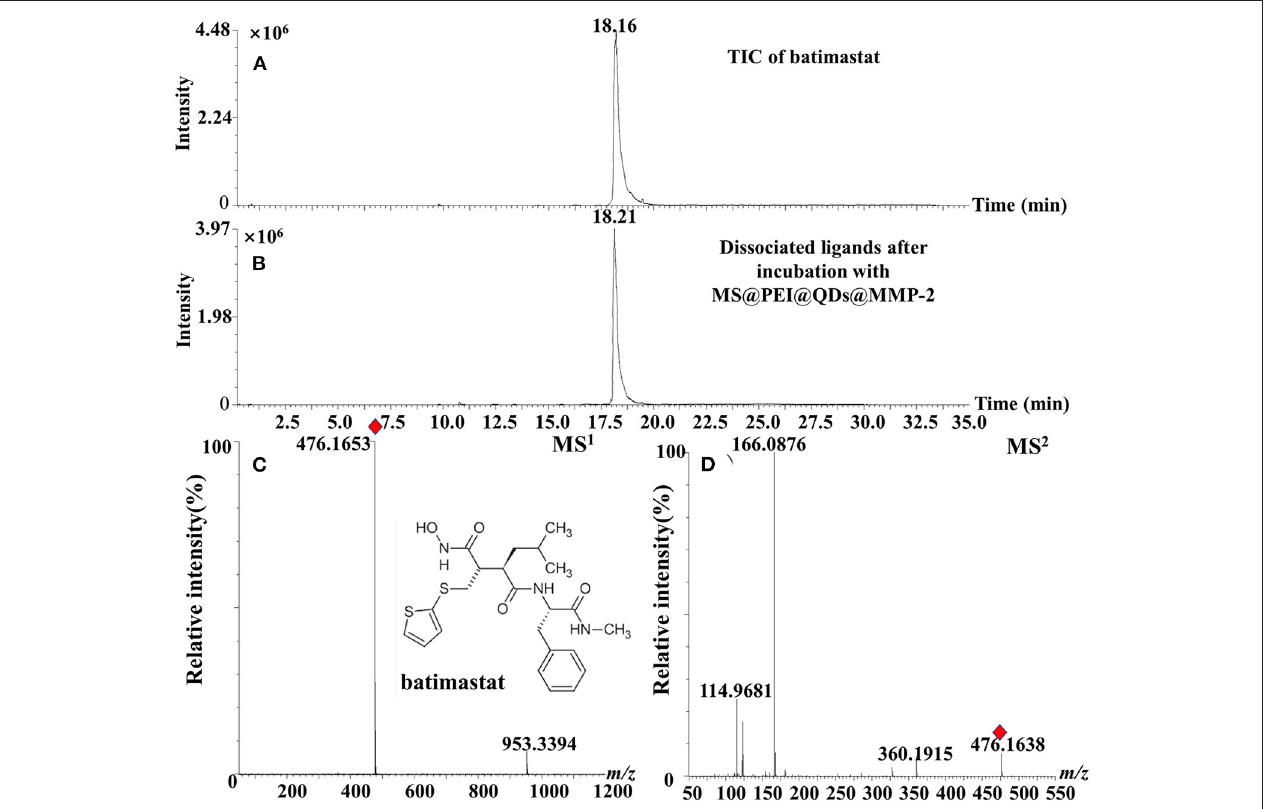
FIGURE 5 | TIC chromatograms of (A) batimastat, (B) dissociated solution after incubation with MS@PEI@QDs@PEI@MMP-2, (C) MS 1 chromatogram, and (D) MS 2 chromatogram of batimastat.